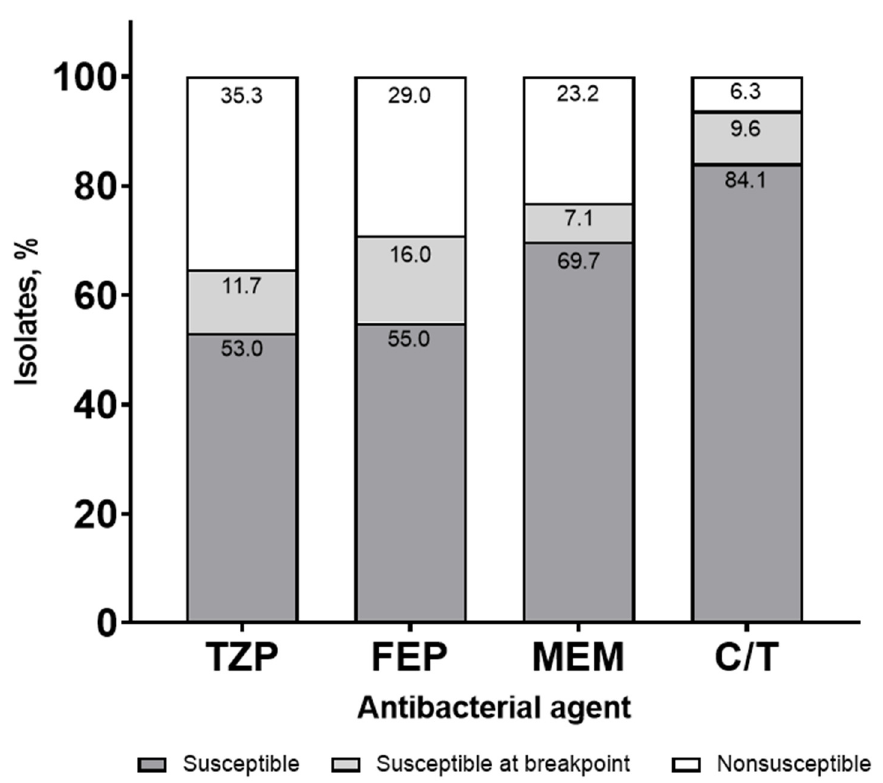
Figure 2. Syndromic antibiogram evaluating susceptibility for Pseudomonas aeruginosa , including isolates susceptible at the minimum inhibitory concentration (MIC) breakpoint collected from a blood or respiratory source stratified by ICU. TZP, piperacillin/tazobactam; FEP, cefepime; MEM, meropenem; C/T, ceftolozane/tazobactam.